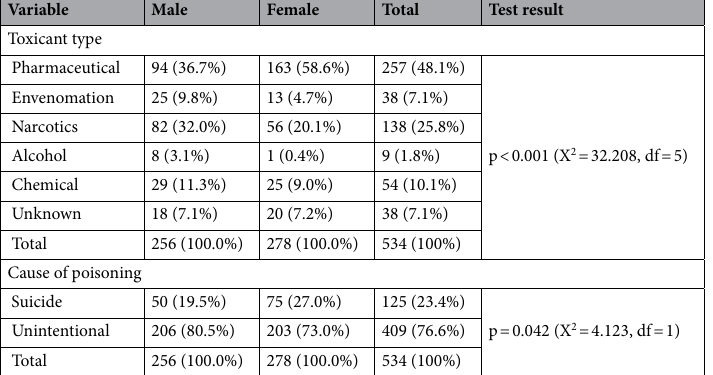
Table 3. Comparison of toxicant type and cause of poisoning by